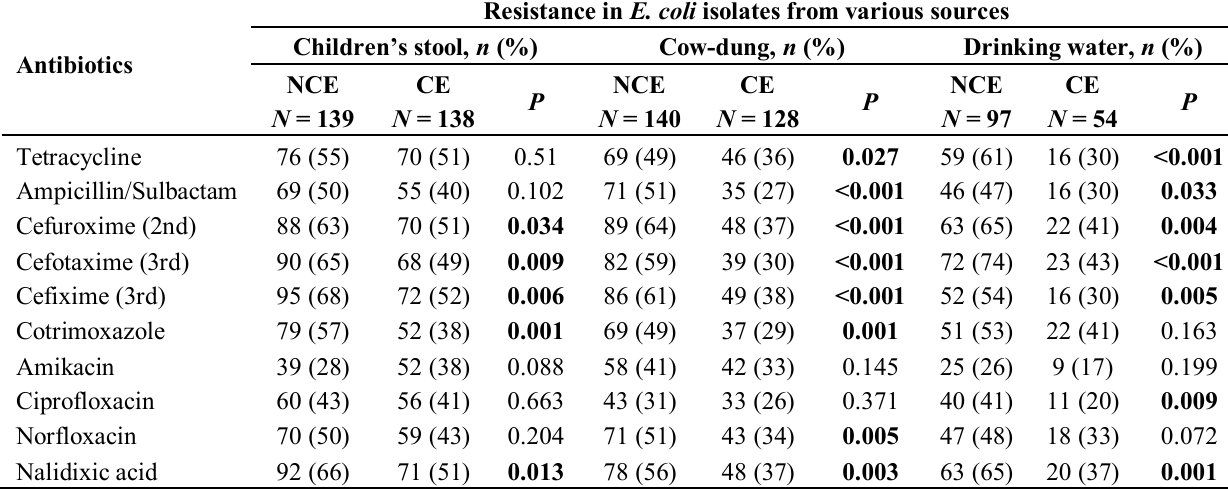
Table 3. Antibiotic resistance pattern of E. coli isolated from children’s stool, cow-dung, and drinking water originating from non-coastal and coastal environment.